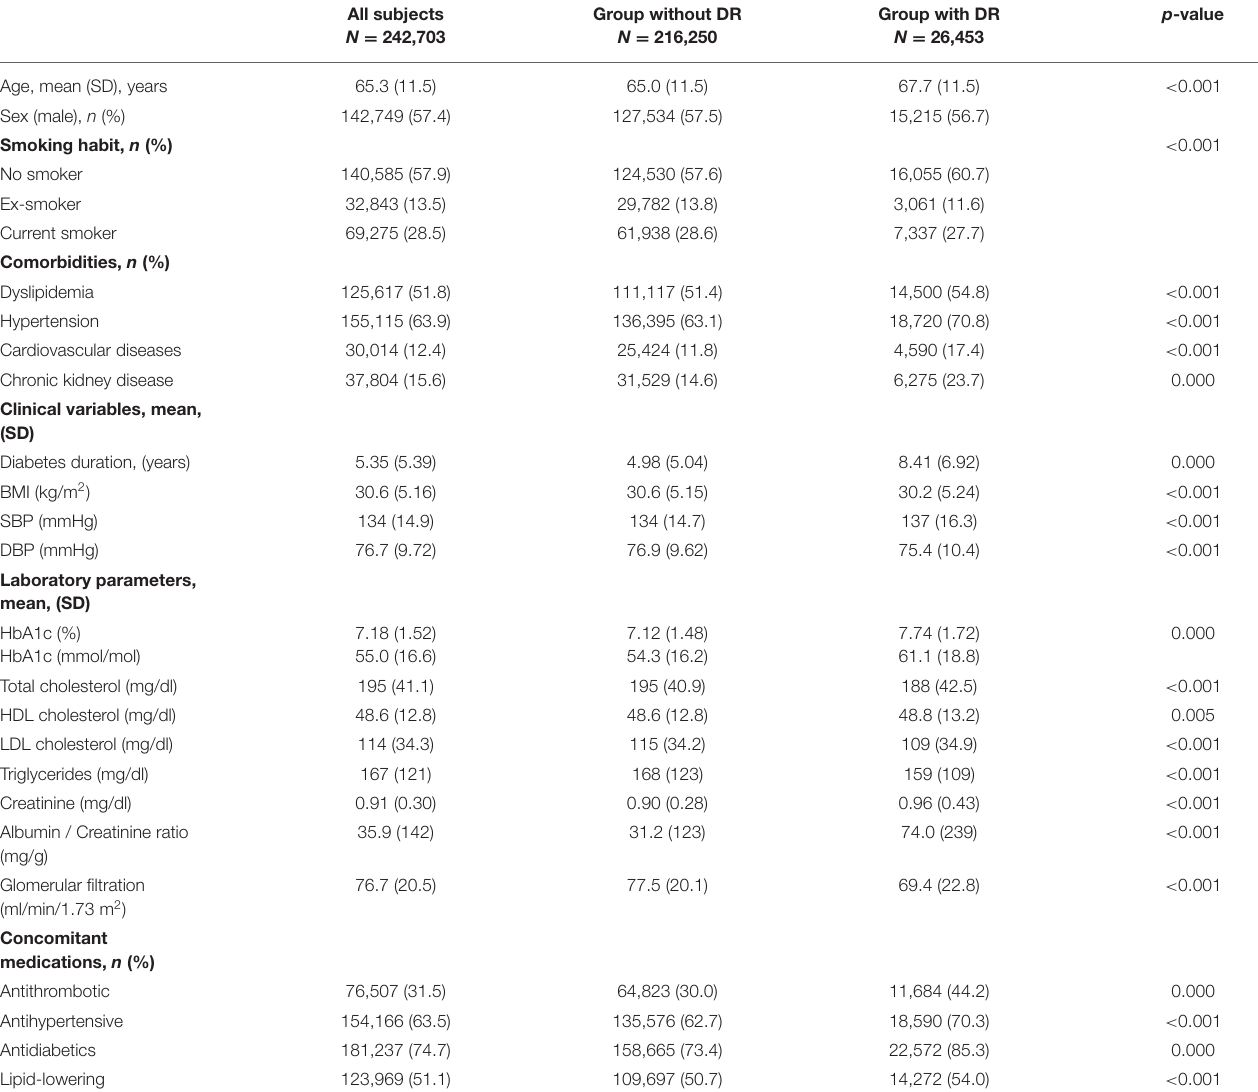
TABLE 2 | Clinical characteristics of the subjects at study inclusion.